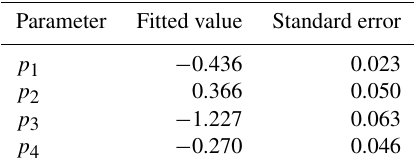
Table 5. Fitted values and standard errors of the four parameters required for the function relating sediment porosity to median grain